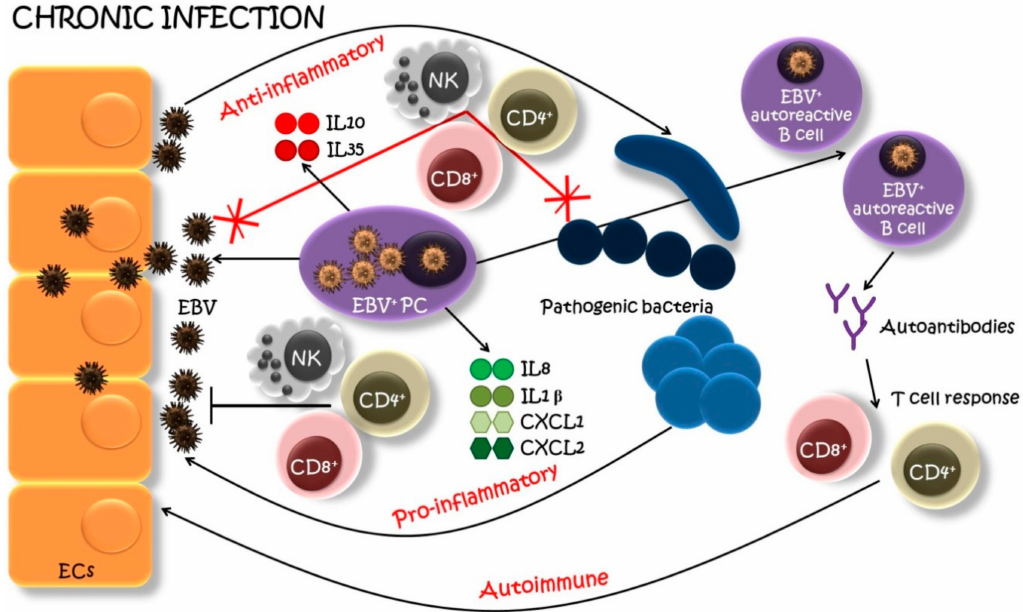
Figure 2. A model of EBV-infected plasma cell’s (PC) involvement in chronic oral infections. EBV-infected PCs (EBV + PCs) infiltrate the site of the oral infection and actively produce EBV within a lesion. New viral particles infect neighboring epithelial cells (EC), which serve as an EBV pool. EBV + PCs, aside of producing immunoglobulins, secret also pro-inflammatory cytokines and chemokines (IL1 β , IL8, CXCL1, CXCL2), recruiting host immune players (natural killers (NK), helper T cells (CD4 + ), cytotoxic T cells (CD8 + ), etc.) to generate a pro-inflammatory reaction. Furthermore, the EBV infection can result in the emergence and proliferation of autoreactive B cells with